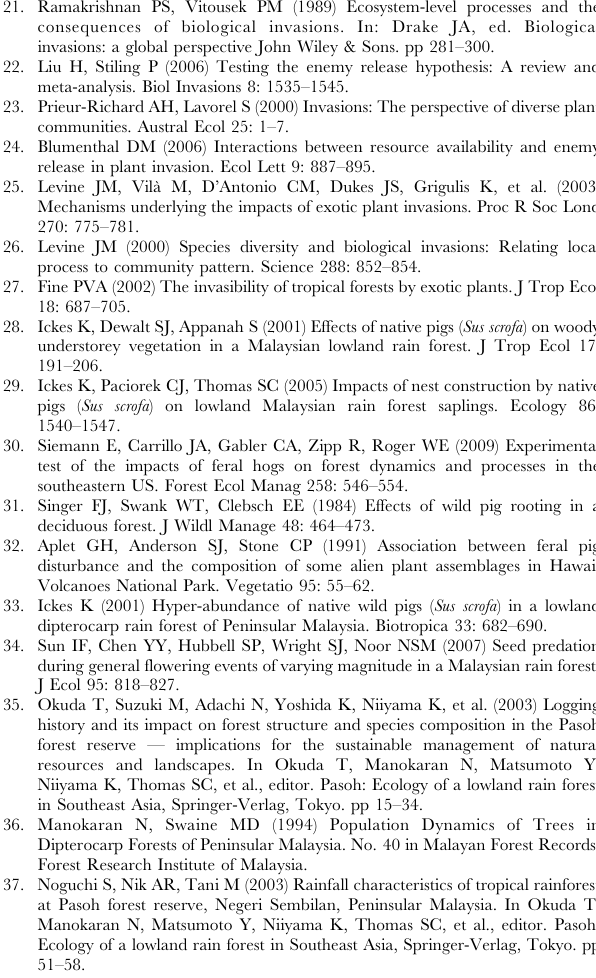
Table S1 Prior probability distributions used in our hierarchical Bayesian model. The symbols in the left-most column correspond to those used in the model (see Methods section, Text S1). k subscript refers to the transect number.